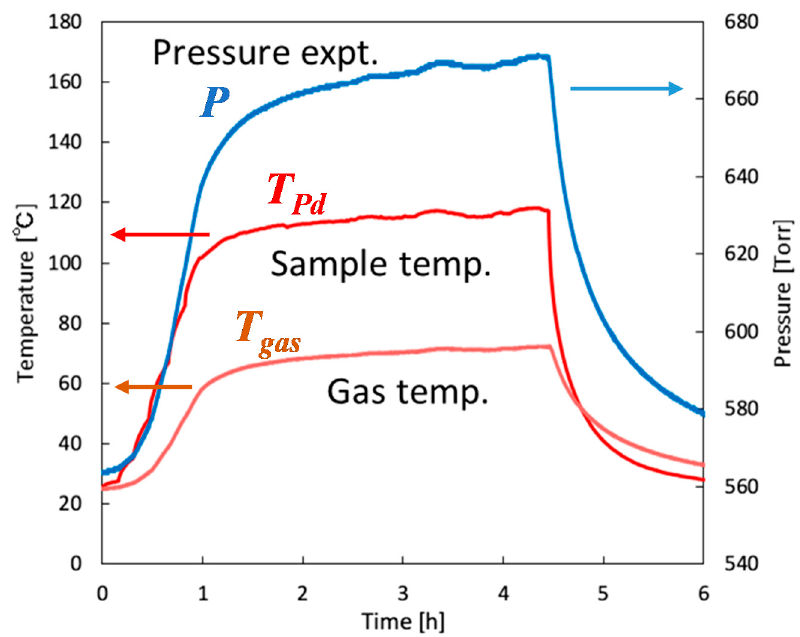
Figure 10. Time evolution of measured Pd temperature, gas phase pressure, and numerically determined gas phase temperature.